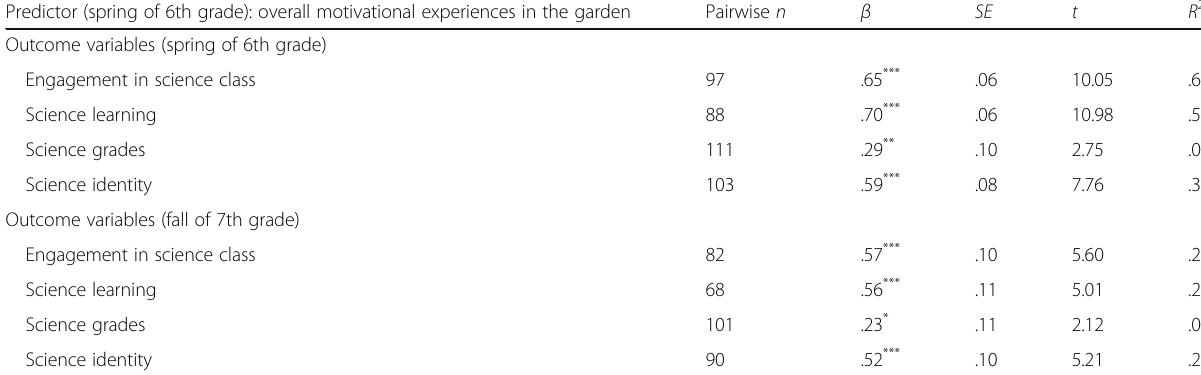
Table 3 Overall motivational experiences in the garden as a predictor of concurrent and later science outcomes Predictor (spring of 6th grade): overall motivational experiences in the garden Pairwise